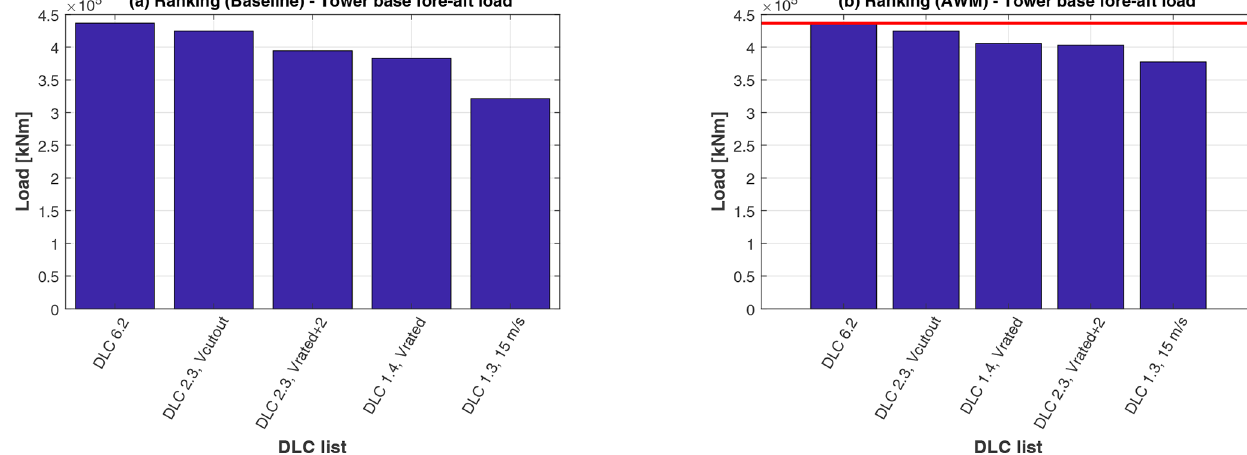
Figure 5. Ranking of ultimate loads for blade root flap-wise load for baseline (b) and PCM (a) in the case of St = 0 . 5 and β PCM = 2 ◦ . The red line shows the baseline ultimate